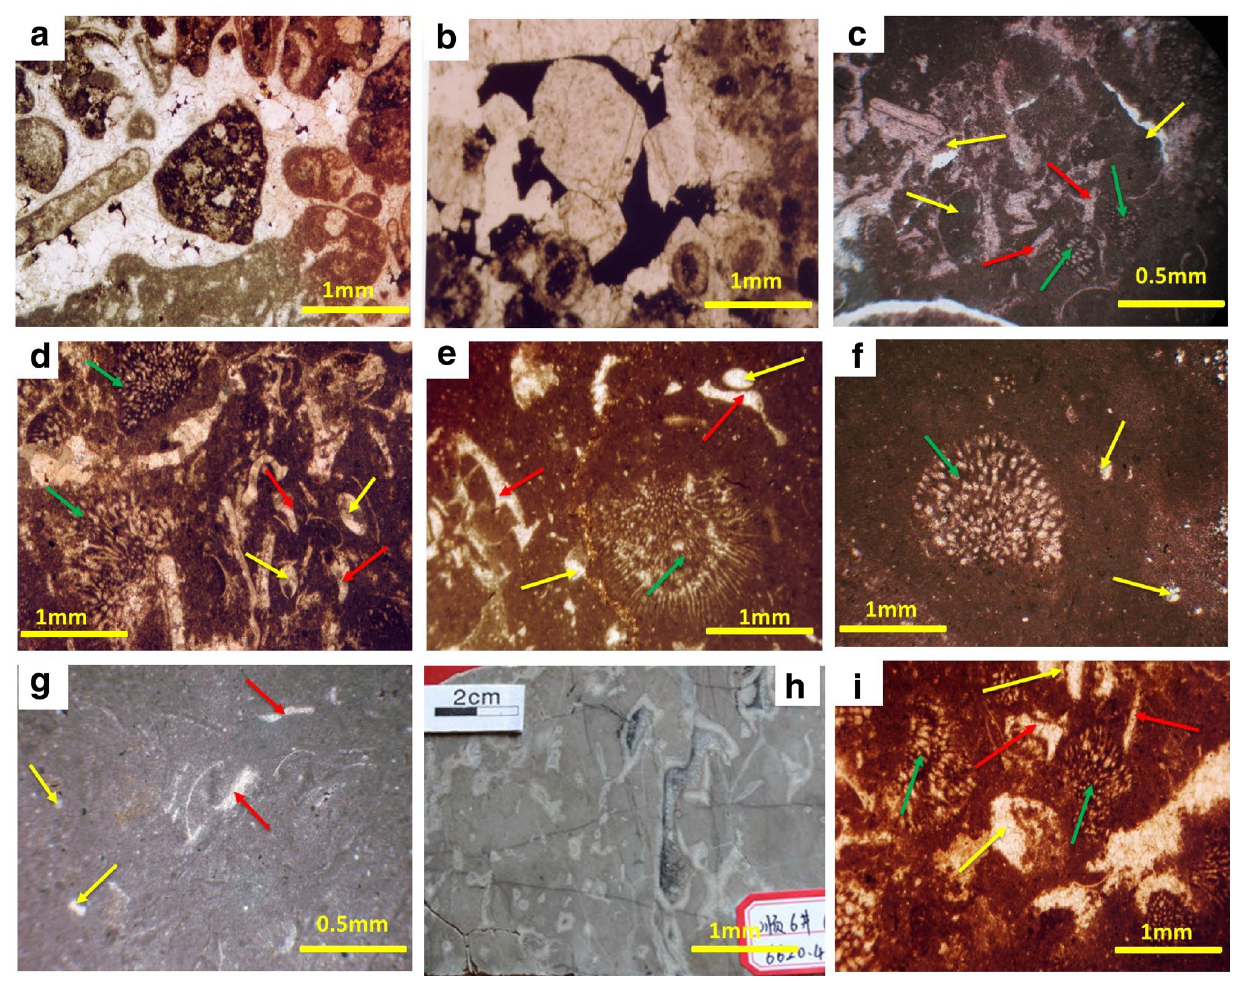
Fig. 6 Photomicrographs of platform reef and shoal microfacies attributes: a bioclastic oncoid packstone (MF-1), under plane polar- ized light (PPL); b argillaceous bioclastic oncoid packstone (MF-1), under PPL; c photomicrograph of ooidal grainstone, dissolved vuggy pores empty, under PPL; d algae packstone-grainstone: ostracods (yellow arrows), oysters (red arrows), algae (green arrows), bryo- zoan (blue arrows) (MF-3), under PPL; e ostracods, oysters, algae floatstone: ostracods (yellow arrows), oysters (red arrow), red cal-